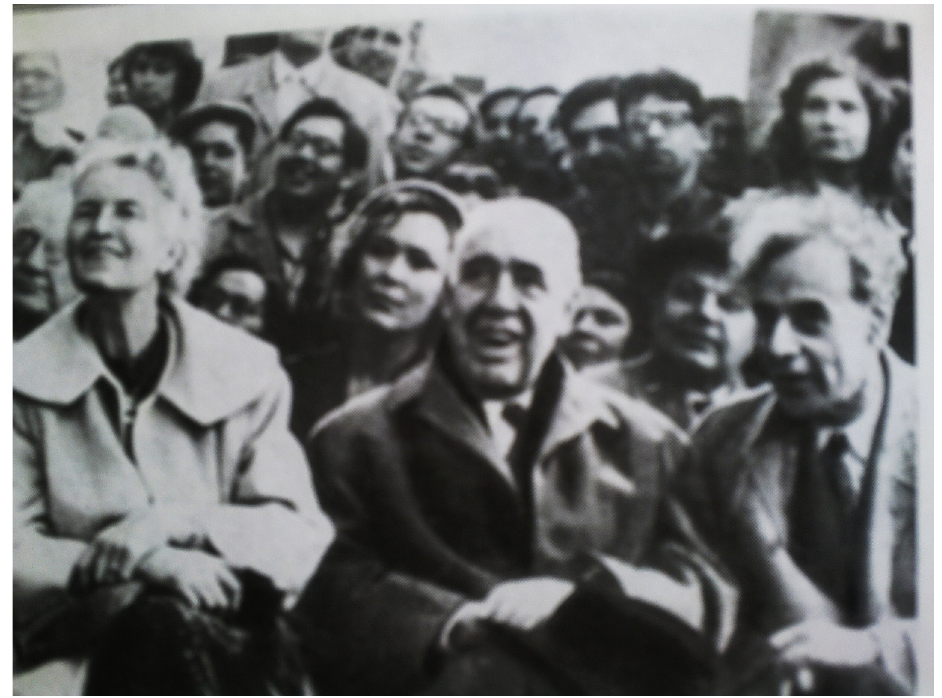
Figure 1. First row (sitting): Margrethe Bohr, Kora Landau, Niels Bohr, Lev Landau. Upper right corner (standing): Nelly Konopleva - student of the 3rd course of Physics Department of Moscow State